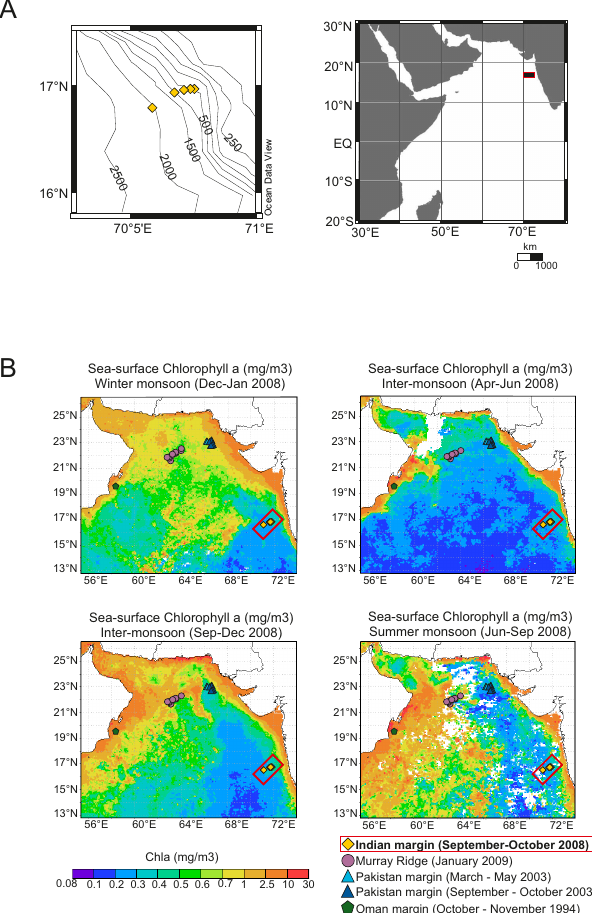
Figure 1. (a) Study area and station location. (b) Sea-surface chlorophyll a concentration (mgm − 3 ) during the monsoonal cy- cle in 2008 at our study sites and previous studies of live benthic foraminifera from the Arabian Sea (Gooday et al., 2000; Schu- macher et al., 2007; Caulle et al., 2014); http://gdata1.sci.gsfc.nasa. gov/daac-bin/G3/gui.cgi?instance_id=ocean_month.